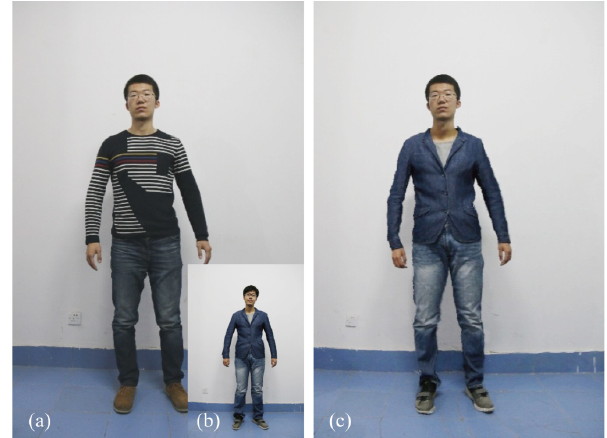
Fig. 1 Example input and output: (a) the user input, (b) model image selection, and (c) the result. basis for the following content-aware image